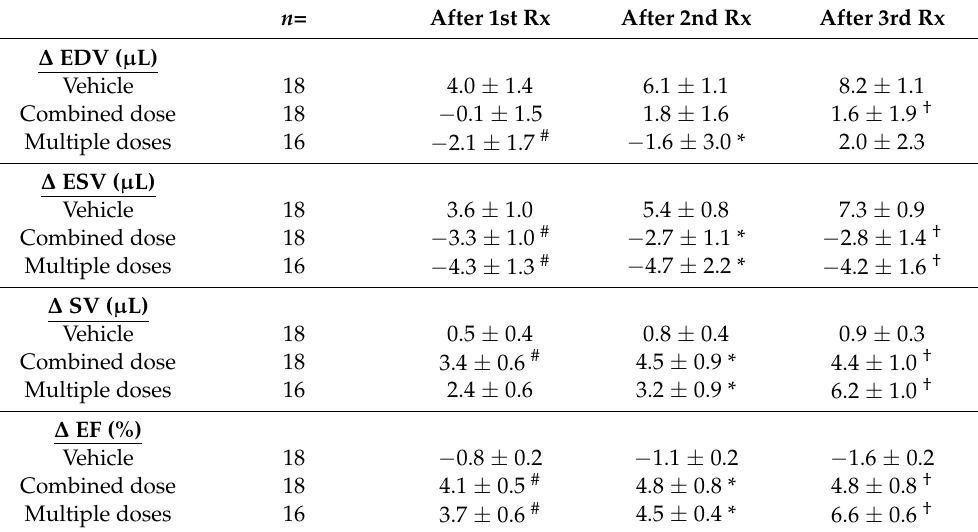
Table 3. Cumulative Change in Echocardiographic Parameters after each